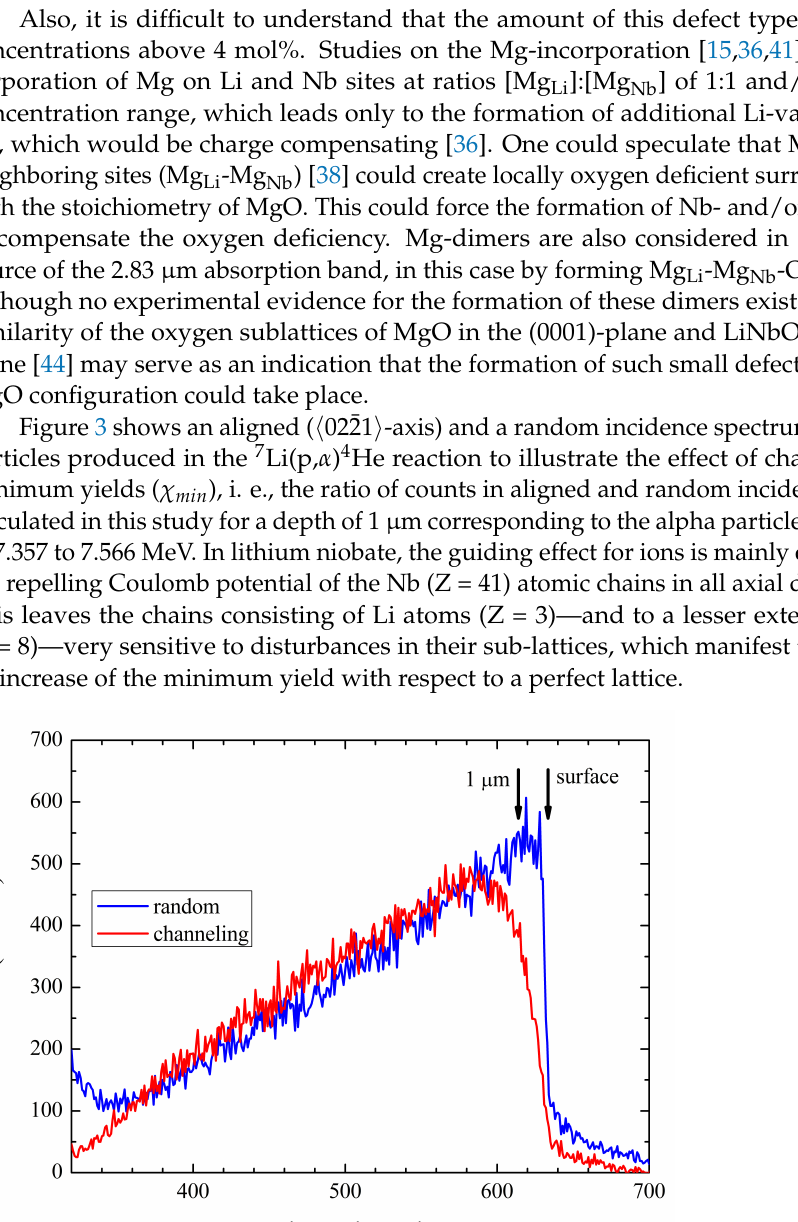
Figure 3. The spectra of the α -particles emitted in the 7 Li(p, α ) 4 He reaction for aligned ( axis) and random incidence of the protons. The spectra are analyzed in the range of 0 (surface) to 1 µ m depth.